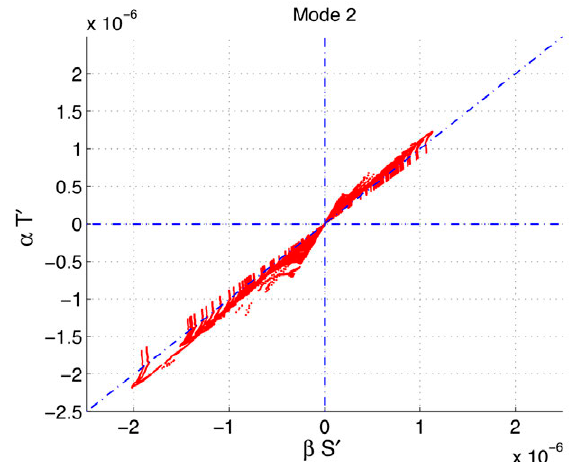
Fig. 7. – Second EOF mode of the anomaly of temperature and sa- linity fields in the range 500-700 m depth (the range of depths at which the WIW-LIW interface is located over